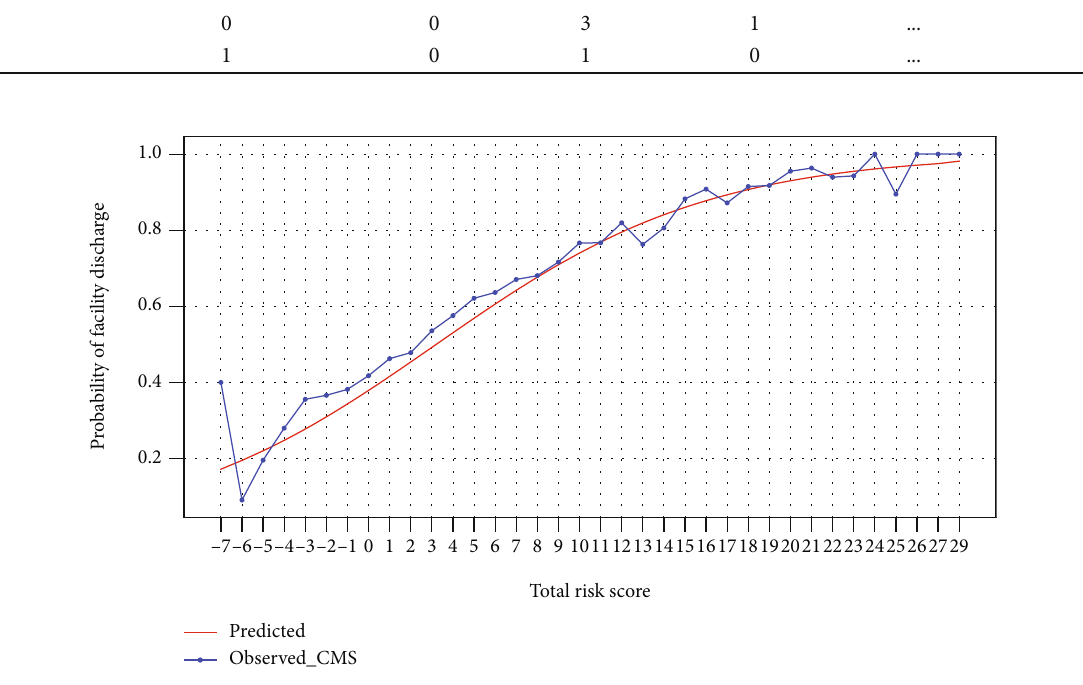
Figure 1: Predicted and observed probabilities of facility discharge for each total risk score. Table 3: Total risk score